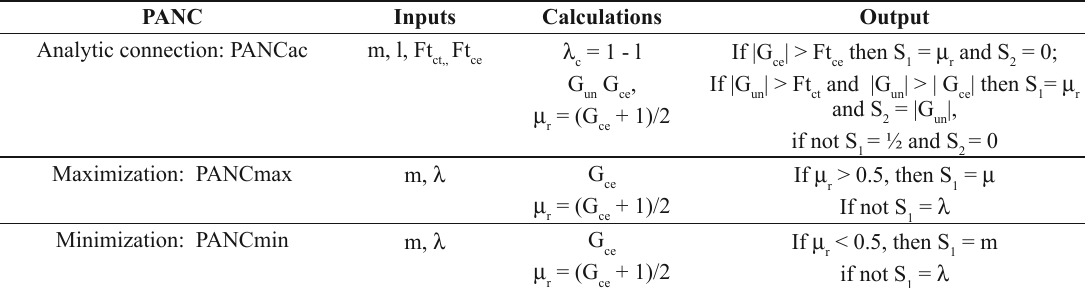
Paraconsistent Arti fi cial Neural Cell.